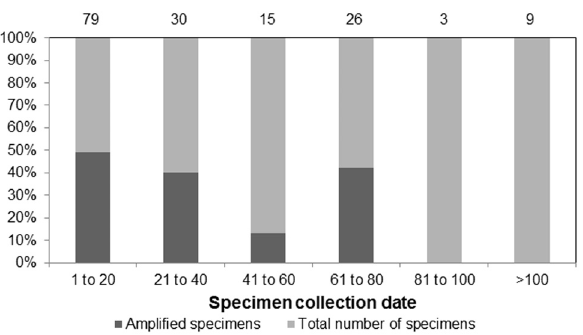
Figure 1 - DNA amplification success (dark grey) according to the collec- tion date of 162 specimens from natural history collections. The numbers above the bars indicate the total number of specimens present in each time period and the numbers below the bars indicate the age of the samples.